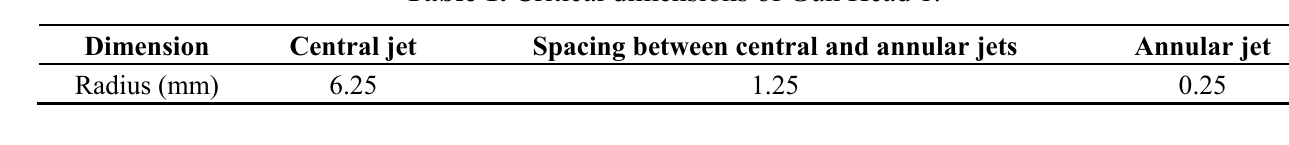
Table 2. Critical dimensions of Gun Head